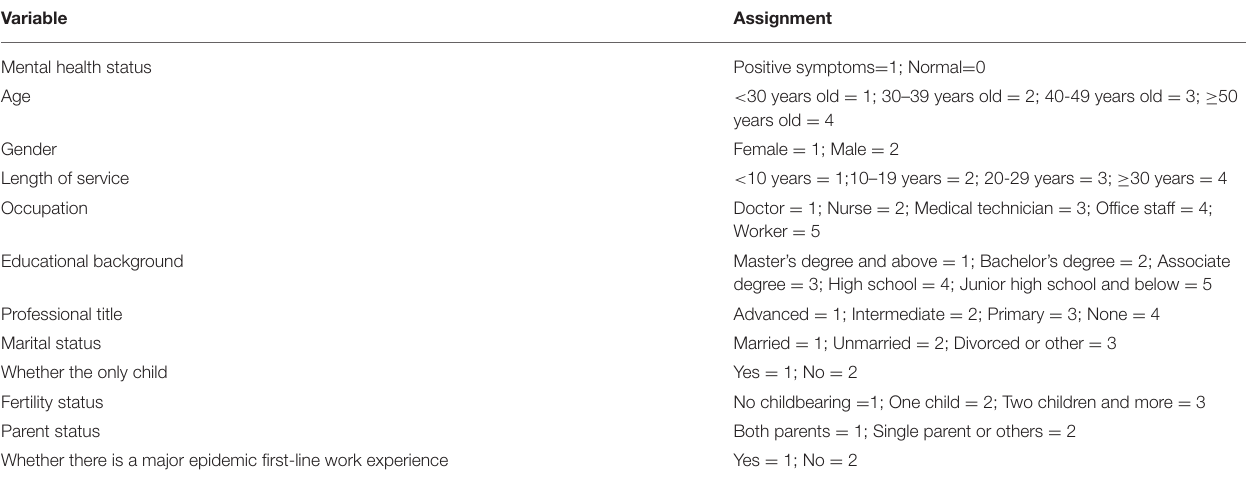
TABLE 3 | Logistic regression analysis variable assignment.